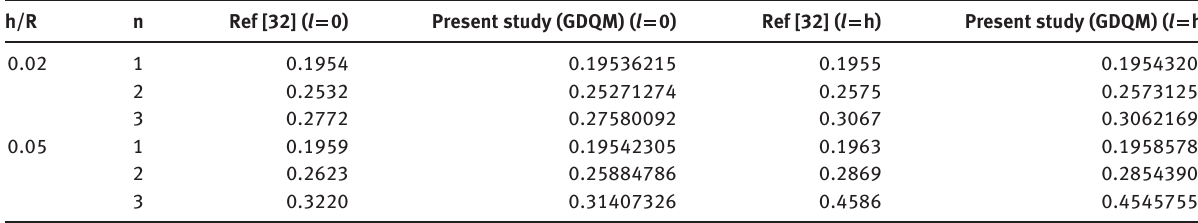
Table 2: Comparison of first three dimensionless natural frequencies of isotropic homogeneous nanoshells, with different thicknesses. h/R n Ref [32] ( l = 0) Present study (GDQM) ( l = 0) Ref [32] ( l = h) Present study (GDQM) ( l = h)